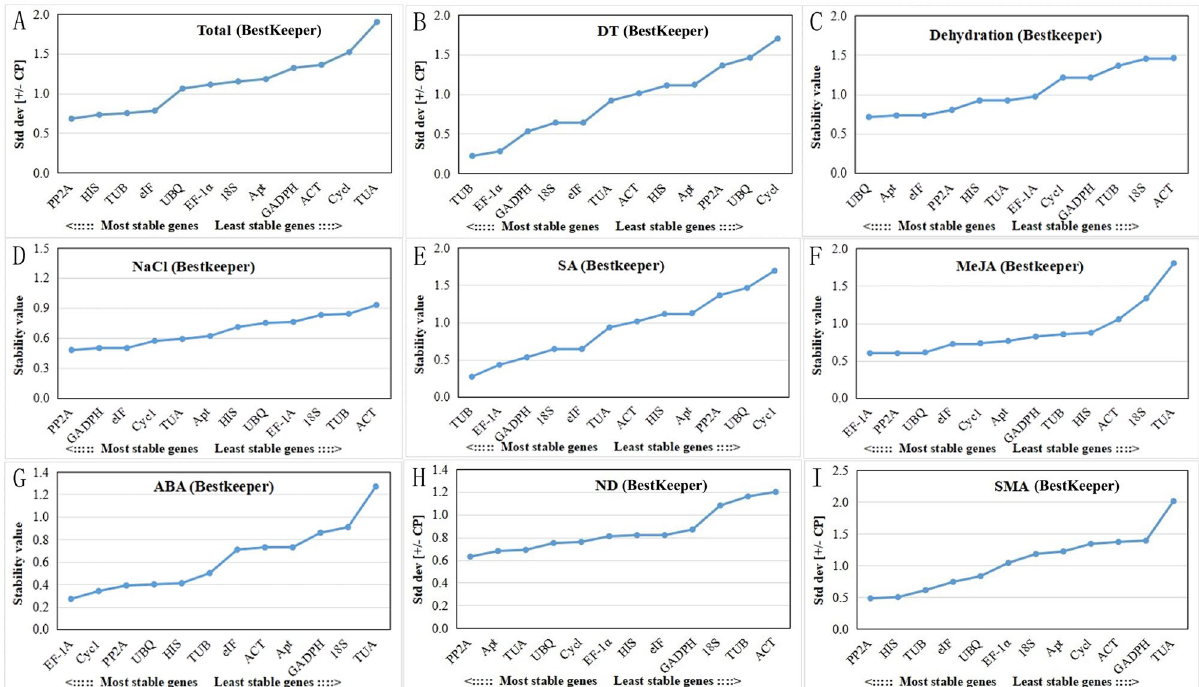
Figure 4. BestKeeper-based expression stability evaluation of 12 candidate reference genes. ( A ) Total: the set of total samples. ( B ) DT: the set with the samples of different tissues. ( C ) Dehydration treatment samples. ( D ) NaCl treatment samples. ( E ) SA treatment samples. ( F ) MeJA treatment samples. ( G ) ABA treatment samples. ( H ) ND: the set with the samples of NaCl and dehydration treatments. ( I ) SMA: the set with the samples of SA, MeJA, and ABA